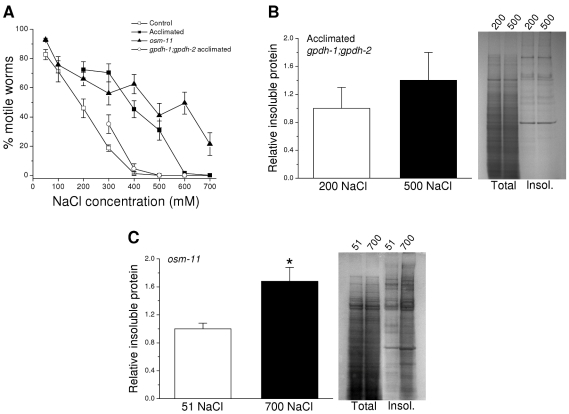
Effect of elevated glycerol levels on hypertonic stress-induced aggregation of endogenous proteins.
A: Effect of increasing NaCl concentrations on motility in control, acclimated, osm-11 and acclimated gpdh-1; gpdh-2 worms. gpdh-1; gpdh-2 mutants lack functional GPDH-1 and GPDH-2 enzymes resulting in greatly reduced glycerol accumulation under hypertonic stress conditions [12]. (n = 5–18 experiments with 15–60 worms/experiment). B: Left panel, relative insoluble protein in acclimated gpdh-1; gpdh-2 worms maintained in either 200 mM NaCl or exposed to 500 mM NaCl for 4 h. Insoluble protein was quantified as a fraction of total protein and is plotted relative to that observed in worms maintained on 200 mM NaCl. (n = 3 experiments with 4000–5000 worms/experiment). Right panel, examples of SDS-PAGE gels of total and detergent insoluble (insol.) proteins isolated from acclimated gpdh-1; gpdh-2 worms maintained in 200 mM NaCl or exposed to 500 mM NaCl. C: Left panel, relative insoluble protein in osm-11 worms grown under control conditions (51 mM NaCl) or exposed to 700 mM NaCl for 4 h. Insoluble protein was quantified and plotted in the same manner as described in B. (n = 3 samples of 4000–5000 worms/sample). *P<0.03 compared to animals maintained on 51 mM NaCl. Right panel, examples of SDS-PAGE gels of total and detergent insoluble (insol.) proteins isolated from osm-11 worms exposed to 51 or 700 mM NaCl.